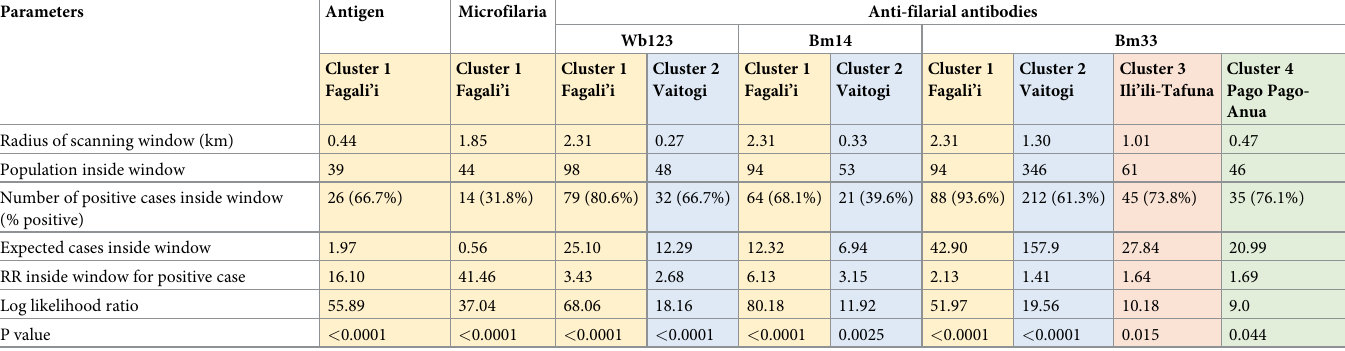
Table 3. Summary statistics from SaTScan using Bernoulli model for identifying significant clusters of lymphatic filariasis infection markers (microfilaria, antigen and antibodies), American Samoa 2016.